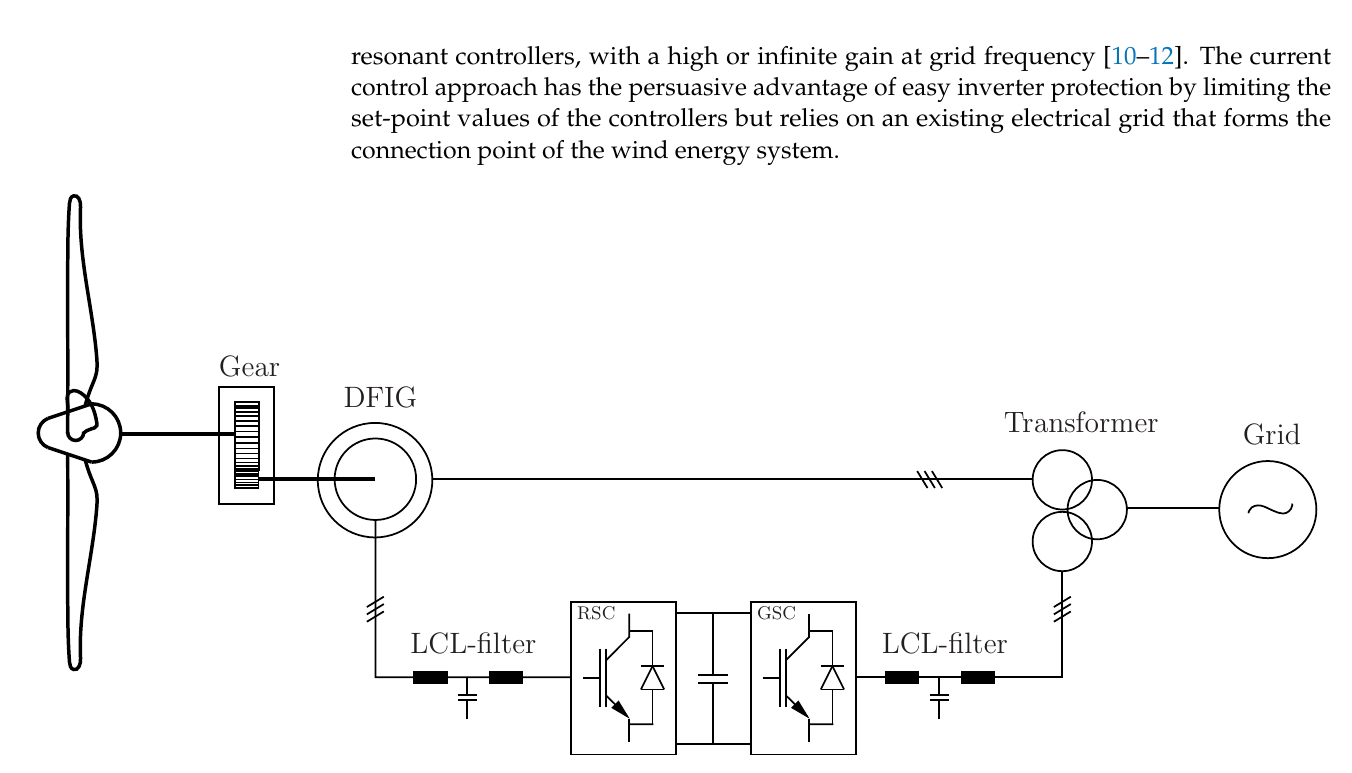
Figure 1. Main structure of electrical power conversion for DFIG-based power